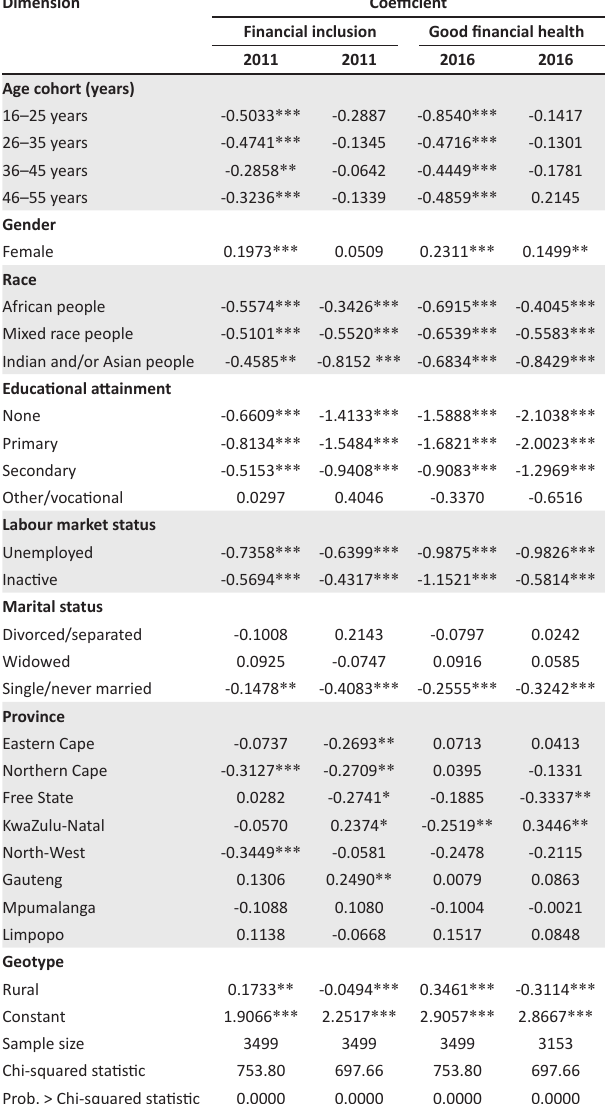
TABLE 7: Probit regressions on good financial health likelihood, with financial inclusion status as an additional explanatory variable. Dimension